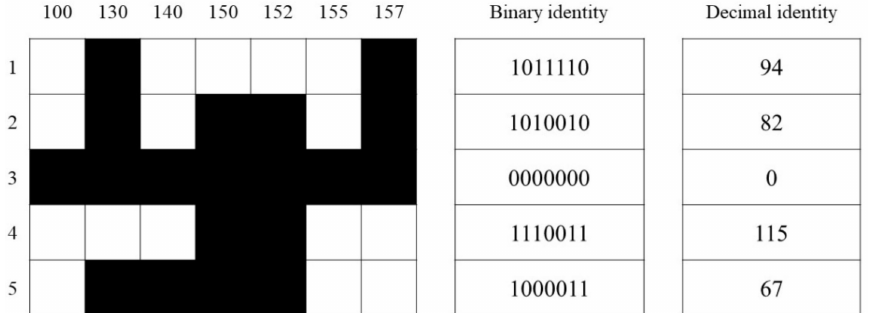
Figure 4. Identification fingerprint of 5 Pennisetum varieties by primer PaSSR11. The numbers 1–5 on the ordinate represent Pennisetum samples (No. 1–5), and the numbers on the abscissa represent the length of alleles; the white squares represent amplified bands, and the black squares represent non-amplified bands. The binary identity is represented as “1” and “0” respectively; the decimal identity is converted from the binary